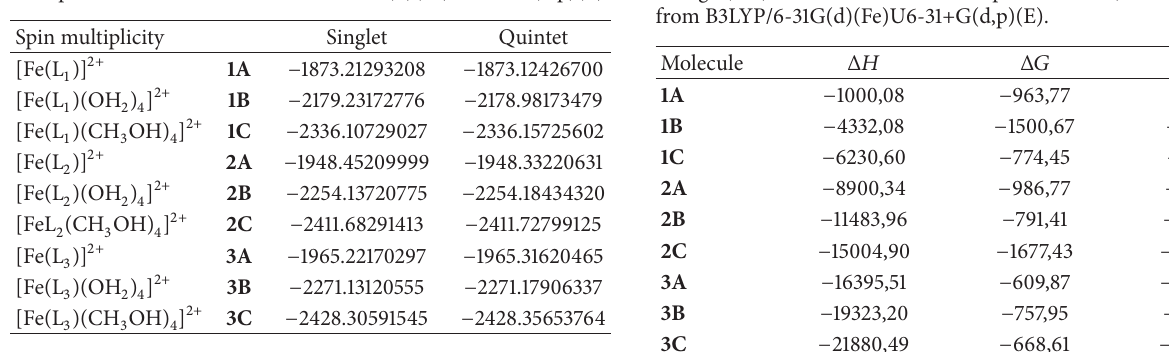
Table 2: Binding energy ( Δ𝐸 int ), enthalpy ( Δ𝐻 ) and free energy change ( Δ𝐺 ) of formation of the complexes all in kJ/mol,